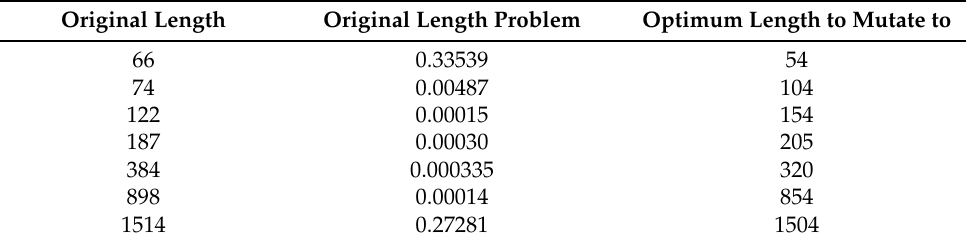
Table 6. Sample of length mapping of Facebook app using OPriv.